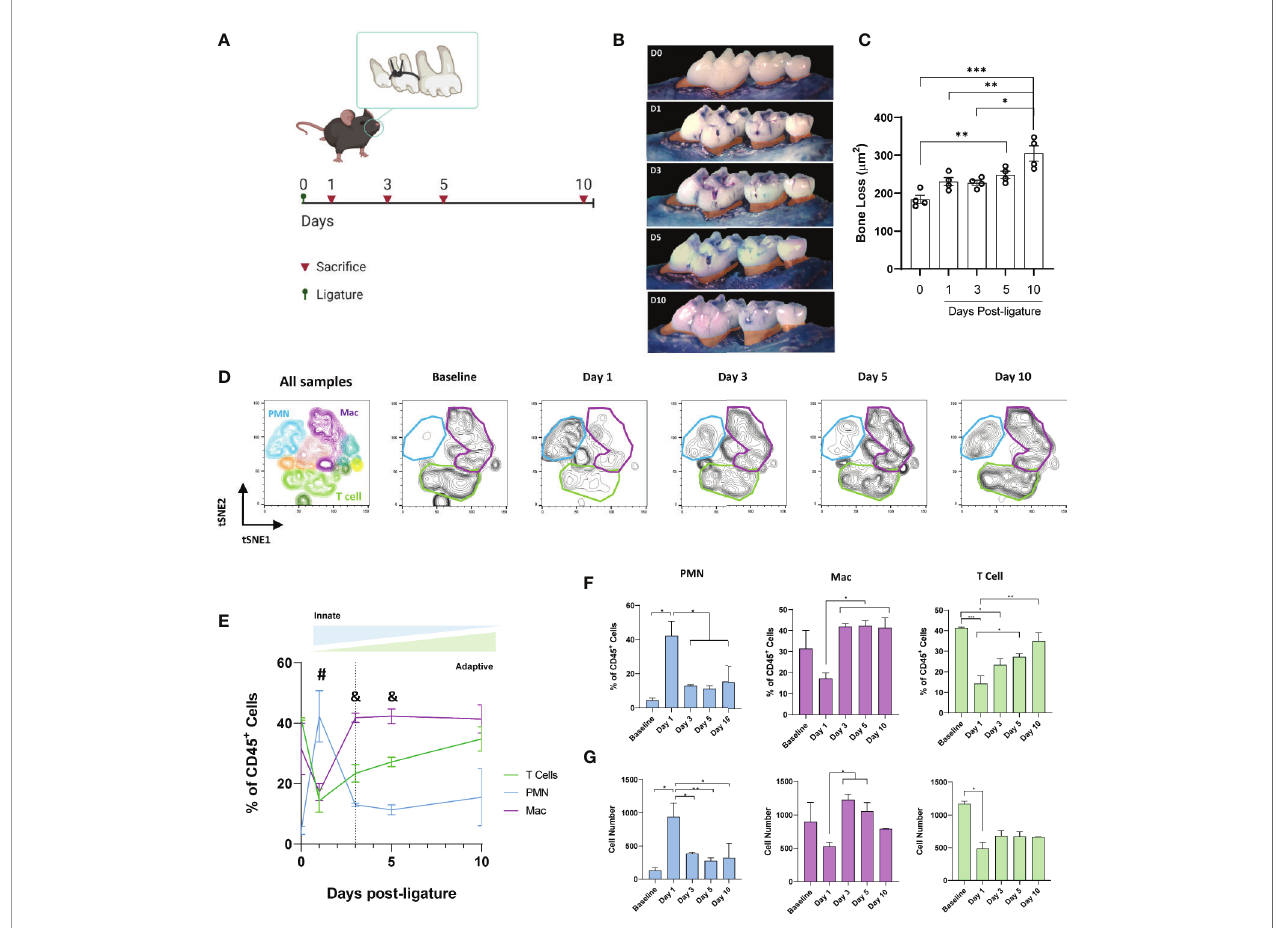
FIGURE 1 | Gingival immune-in fi ltrate shift during experimental periodontitis progression. (A) Experimental design. (B) Representative palatal views of maxillary molars from animals at baseline (D0) or sacri fi ced at days 1, 3, 5, or 10 after ligature placement. Bone loss area is highlighted in orange. (C) Bone loss measurements from the cementoenamel junction to alveolar bone crest. (D) Identi fi cation of gingival neutrophils (PMN, CD45 + LY6G high LY6C mid CD11b + ), macrophages (Mac, CD45 + CD64 + CD11b + MHCII + ), and T cells (CD45 + CD3 + ) as clustered by FlowSOM. tSNE graphs of concatenated data (4 animals per group) showing CD45+ gingival cells. (E) Comparison of the peak frequencies of PMN, T cells, and macrophages within CD45 + gingival cells over time. Dotted line represents day 3 (highlighting transition from innate to adaptive immune response) (F) Percentages and (G) cell number of neutrophils, T cells, and macrophages in gingiva. # P<0.05 PMN vs T cell and Mac; & P < 0.05 Mac vs T cell and PMN; *P < 0.05; **P 4< 0.01; ***P <